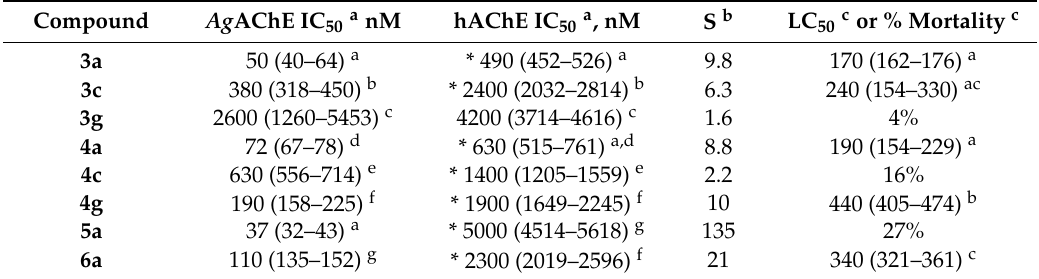
Table 2. Enzyme inhibition potency and toxicity to adult female An. gambiae of chemical structures shown in Figure